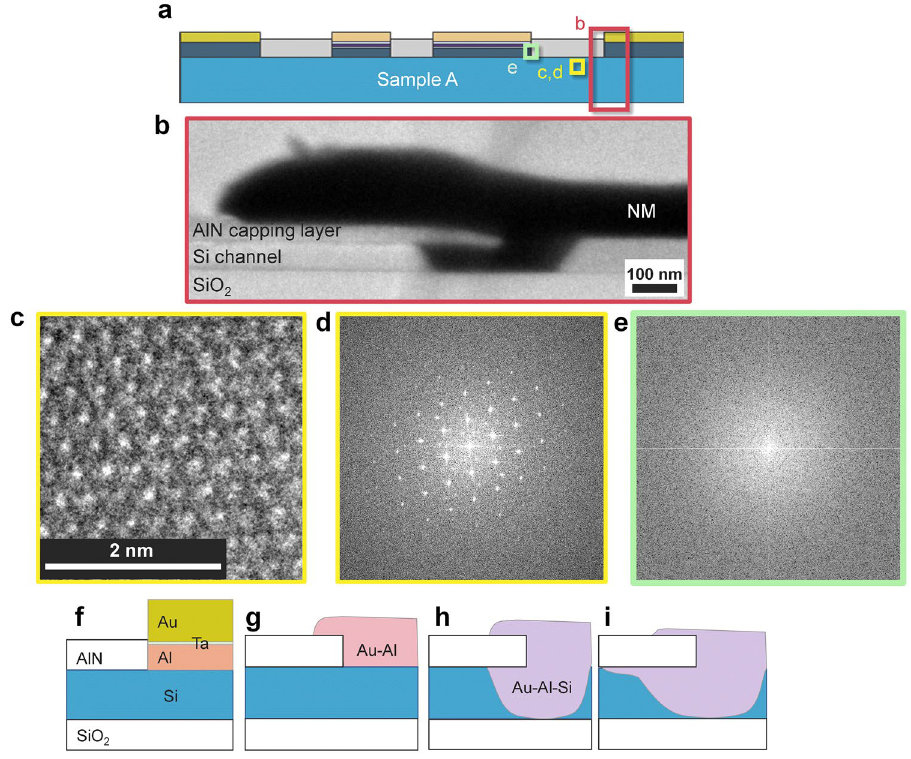
Figure 3. Crystallographic analyses of the Si channel after annealing and a possible degradation mechanism by annealing. ( a ) A schematic cross-section of sample A. The areas of TEM observations are roughly indicated by red and yellow squares. ( b ) A cross-sectional TEM image of the NM electrode obtained at the red square shown in ( a ). ( c ) An atomic-resolution TEM image obtained at the Si channel indicated by the yellow rectangle in ( a ) and ( d ) the Fourier transformation of the area. ( e ) A Fourier transformation of the area of Au diffusing along AlN/Si interface. ( f ) – ( i ) Schematic images of the possible mechanism of diffusion of the Au atoms during annealing. ( f ) the fabricated structure. ( g ) Au-Al intermetallics were formed, and Au reached Si. ( h ) The intermetal of Au-Al-Si was formed, including the liquid phase. ( i ) The liquid phase diffused through the interface of